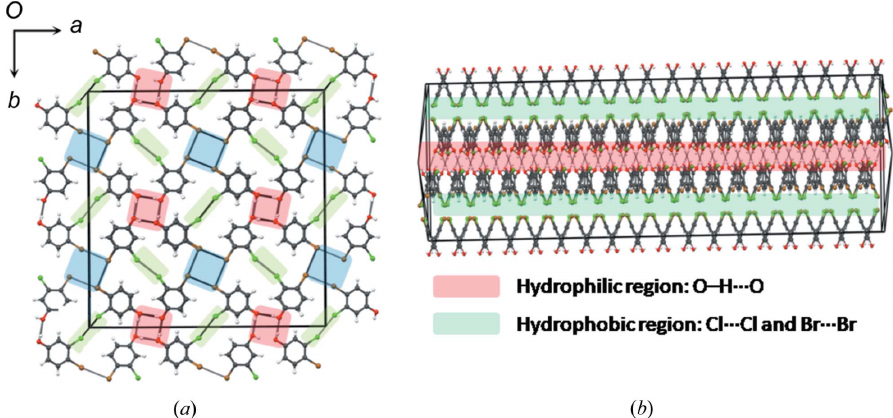
Figure 2 4-Bromo-3-chlorophenol ( 2 ): ( a ) Hydrogen bond and halogen bond pattern, O—H (cid:2)(cid:2)(cid:2) O (red), type II Br (cid:2)(cid:2)(cid:2) Br (blue) and type I Cl (cid:2)(cid:2)(cid:2) Cl (green). ( b ) Calculated Bravais–Friedel–Donnay–Harker (BFDH) morphology showing hydrophilic core and hydrophobic exterior. This makes the structure anisotropic in orthogonal directions. Colour code: hydrogen bond region (red), halogen bond region